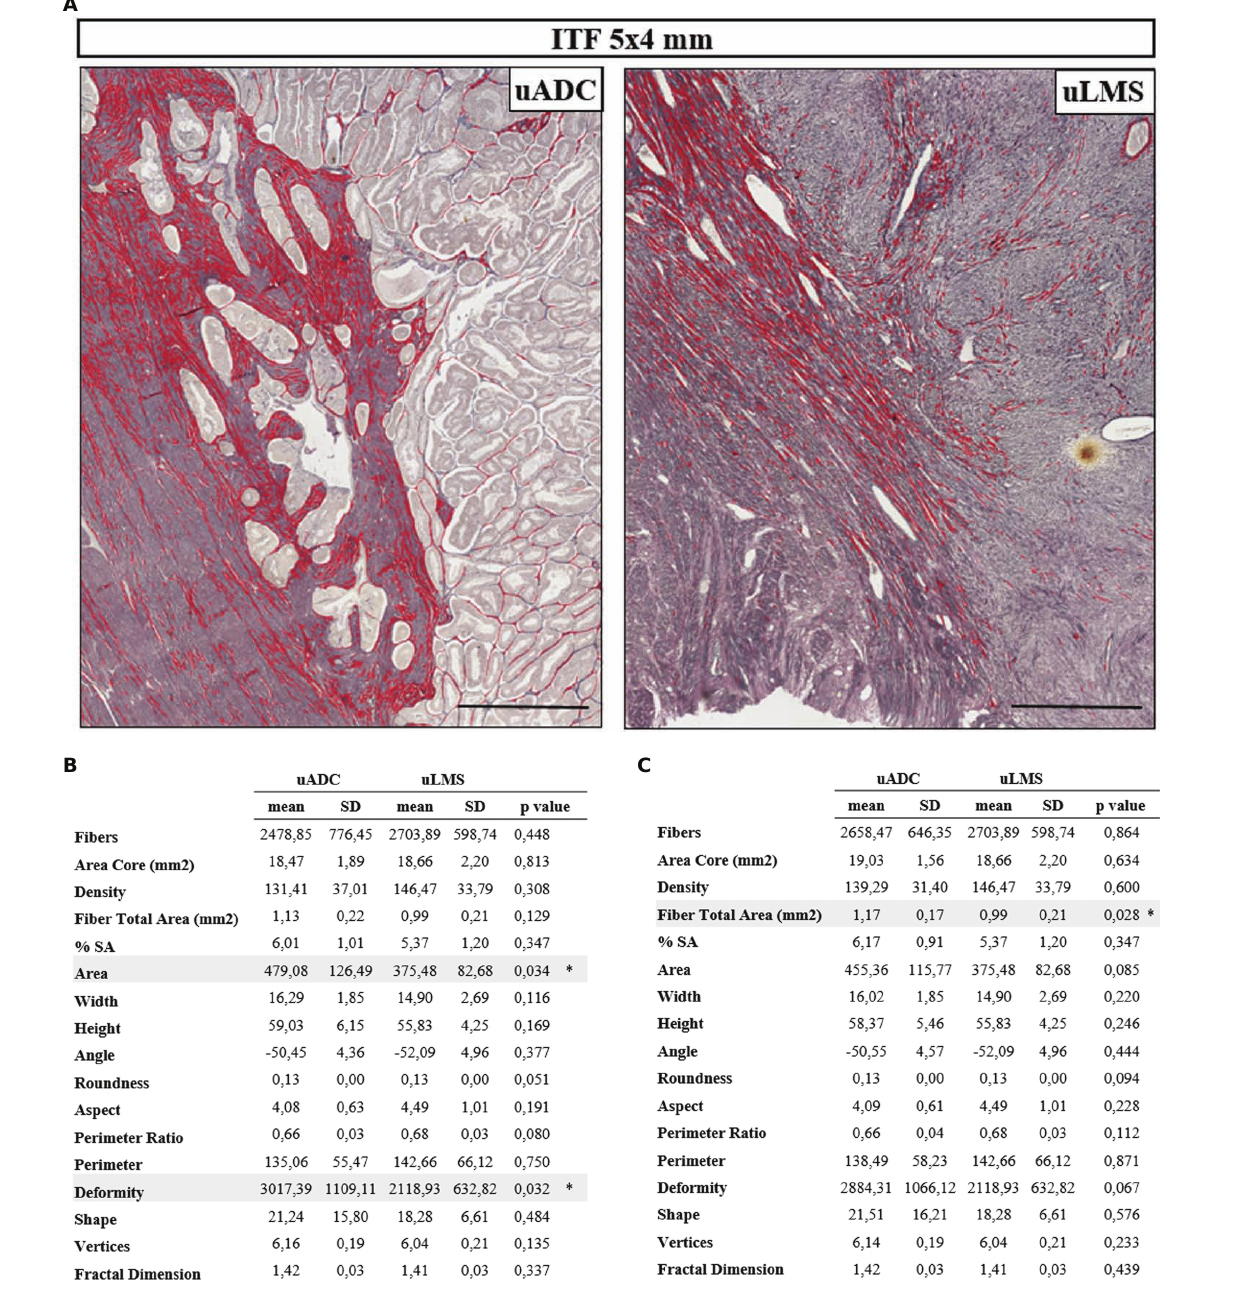
included in any run. Library denaturation was performed by first adding 2N NaOH, followed by addition of 2N HCl. The PhiX was spiked in at 5% (concentration of